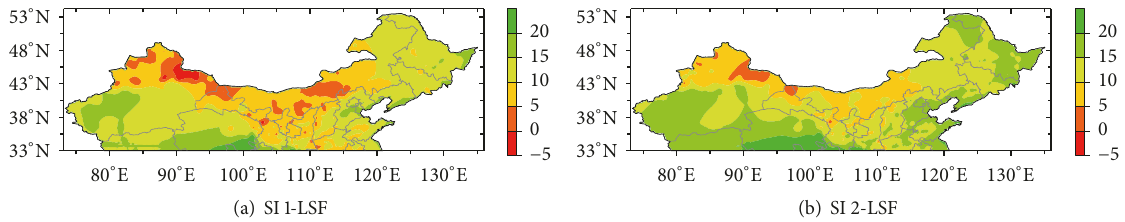
Figure 8: Average differences (days) in the start of the growing season between SI 1, SI 2, and the last spring frost (LSF) date in northern China during 1961–2015.